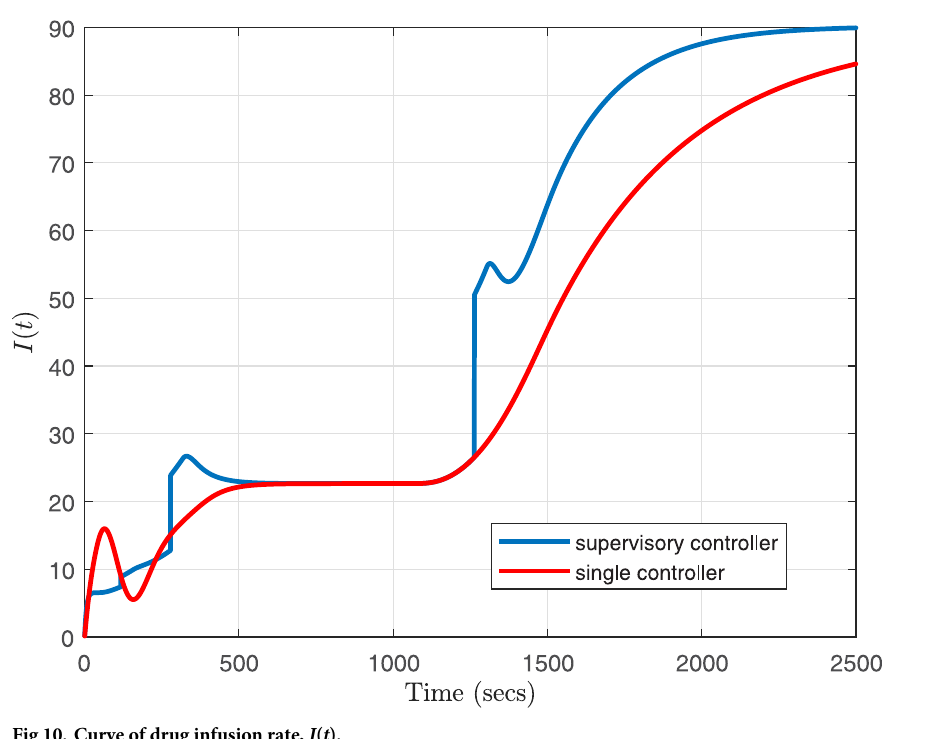
Fig 10. Curve of drug infusion rate, I ( t